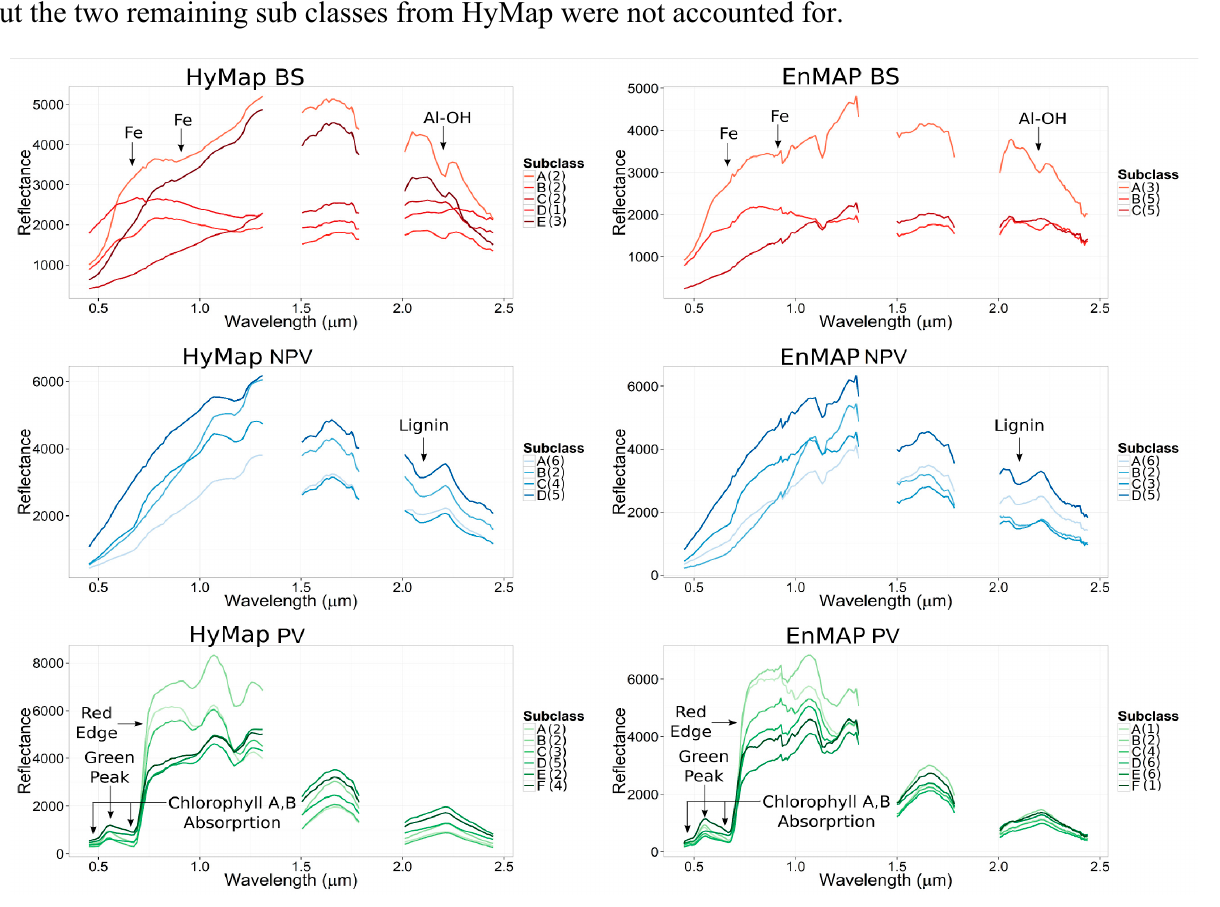
Figure 3. HyMap and EnMAP PV, NPV and BS classes and sub classes (for clarity